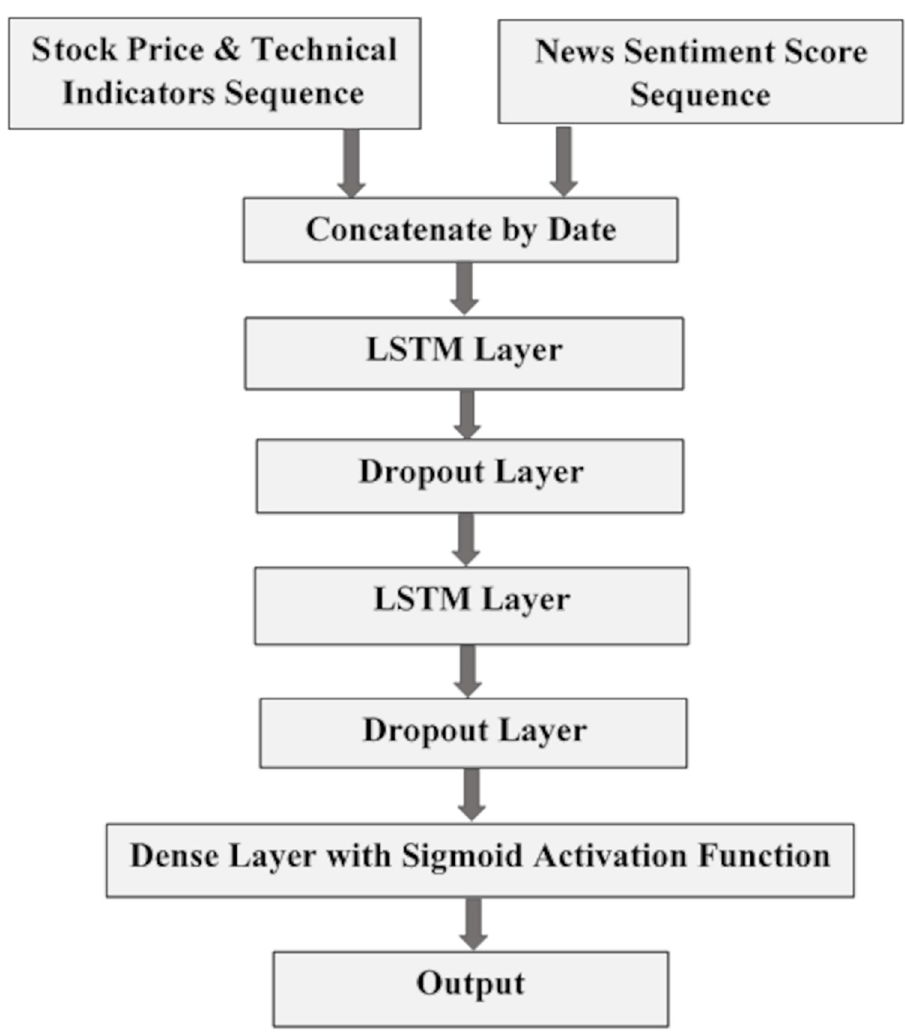
Fig 3. Architecture of the baseline prediction